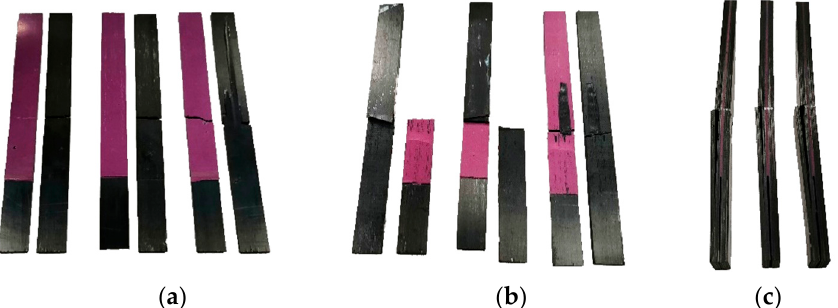
Figure 5. Inspection of ENF failure surfaces of: ( a ) untreated specimens; ( b ) 13% laser treated specimens; ( c ) 20% laser treated specimens.